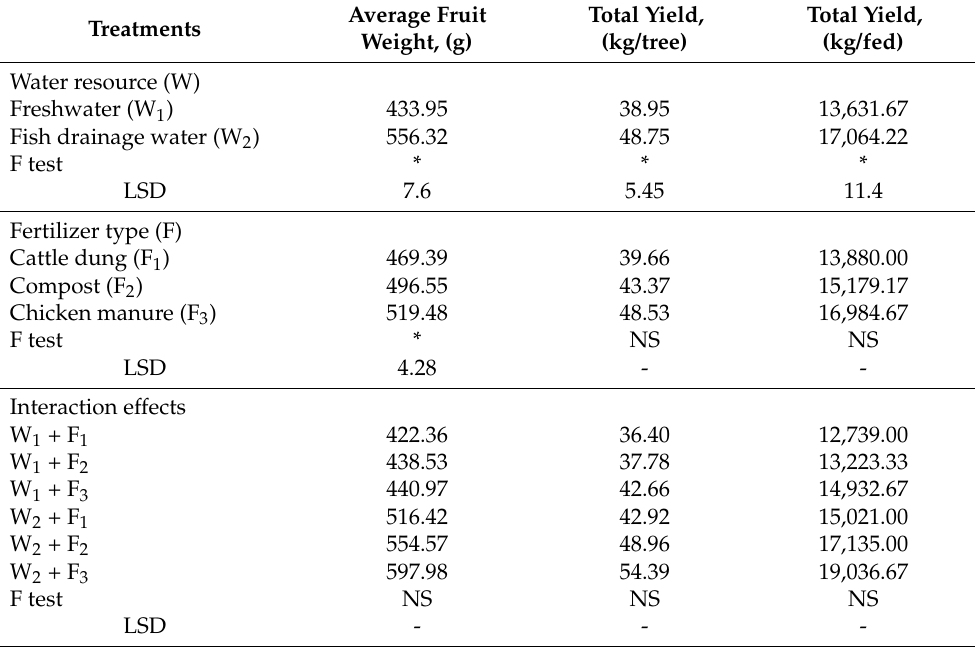
Table 6. Fruit yield and its components of pomegranate trees under different water resource and fertilizer